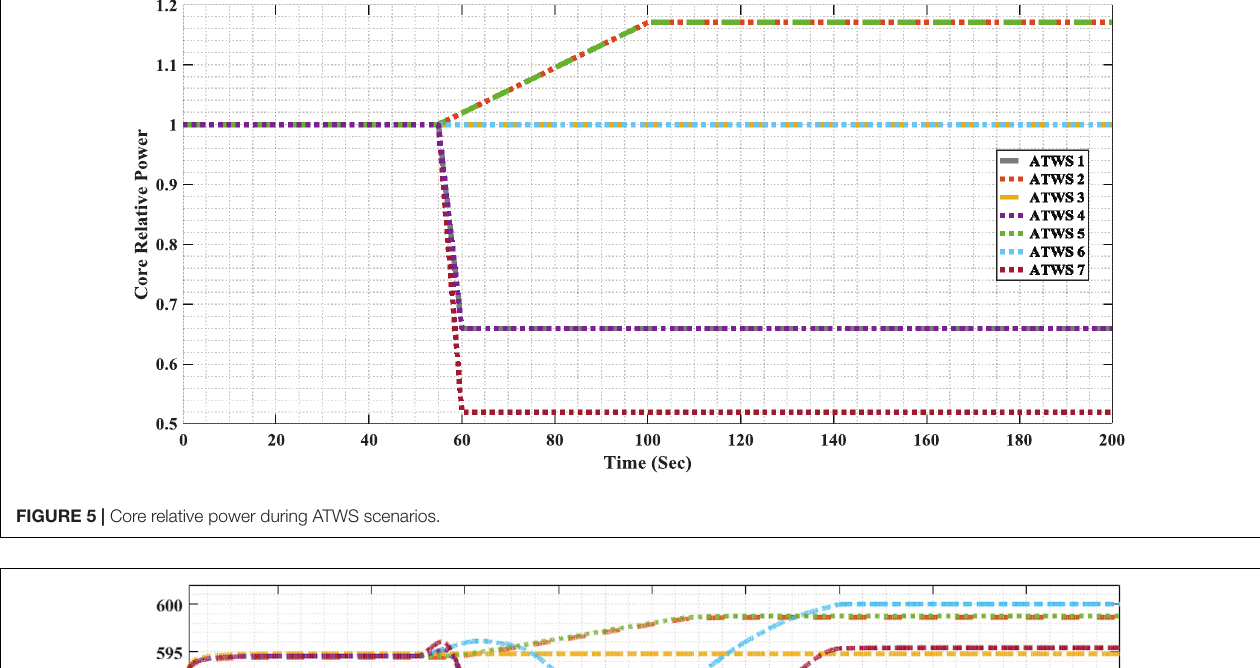
FIGURE 5 | Core relative power during ATWS scenarios.